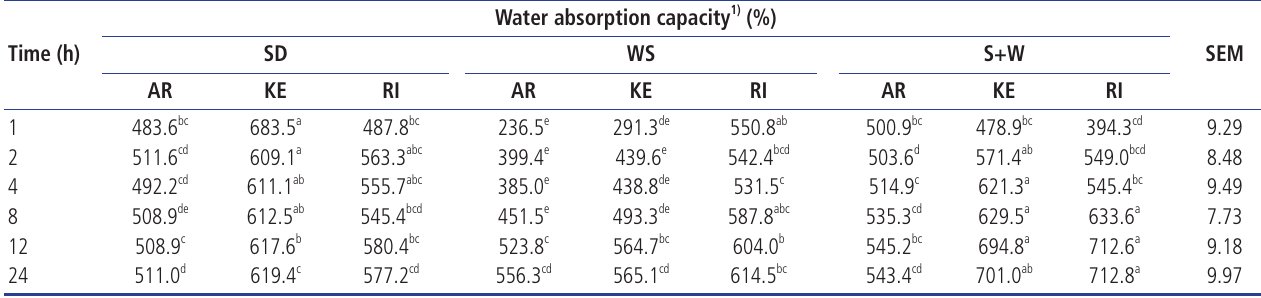
Water absorption capacity 1)